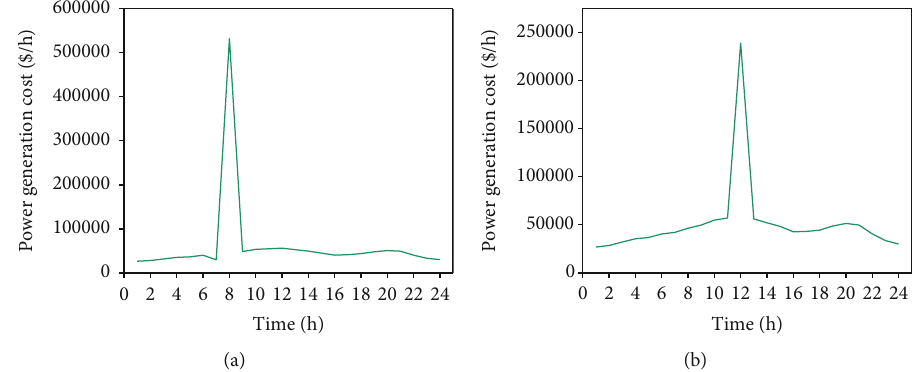
Figure 9: Hourly power generation costs of the 24h DED for LP5 at 30% solar penetration under (a) abundant and (b) scarce solar resource conditions.